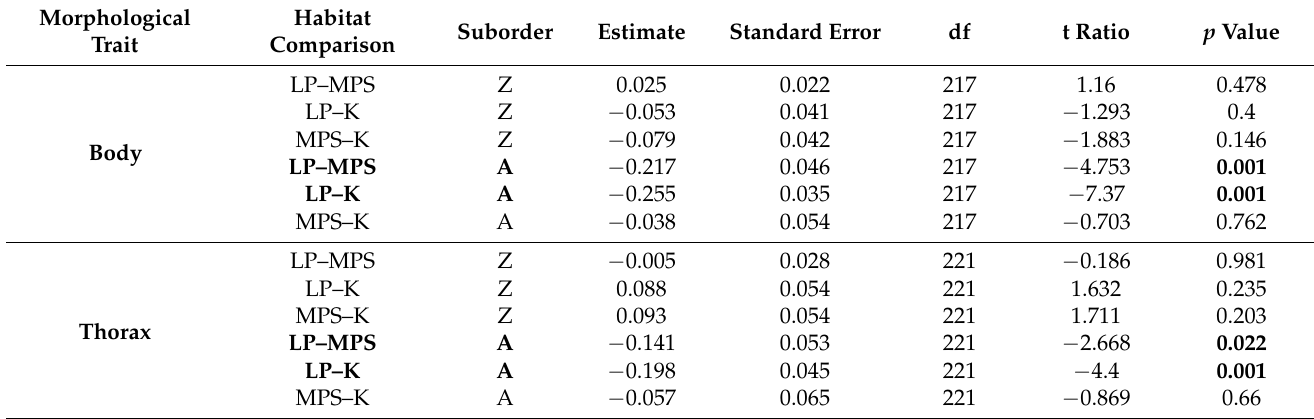
Table 1. The statistical test results of the generalized linear models (GLMs) for morphological traits body length, thorax length, hind wing length, and hindwing-to-body ratio compared across habitat types—mixed peat swamp (MPS), low pole (LP), and kerangas (K), and controlling for suborder— Anisoptera (A) and Zygoptera (Z). The estimate is the marginal difference between the first habitat compared to the second. Significant differences found are